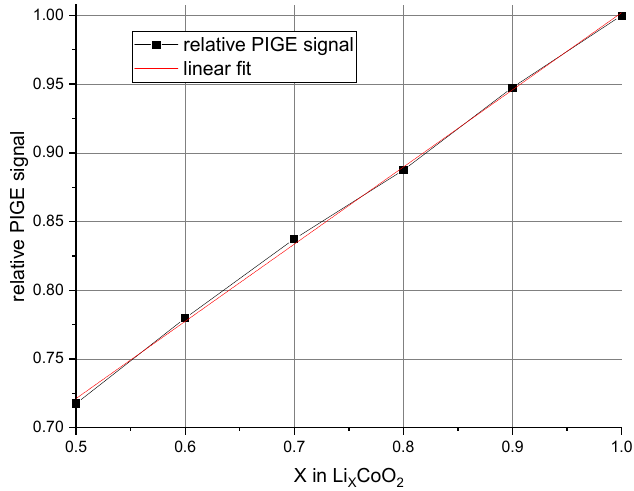
Figure 11. The relation between PIGE signal intensity calculated by SimNRA7.02 and amount of Li in the mixed cathode is linear (R 2 = 0.999) for the assumed LCO + LLZ 1:1 mixture. The decrease of signal intensity is only 28%, due to the limited amount of mobile Li in LiCoO 2 and the 1:1 wt.% mixture of LCO and LLZO.